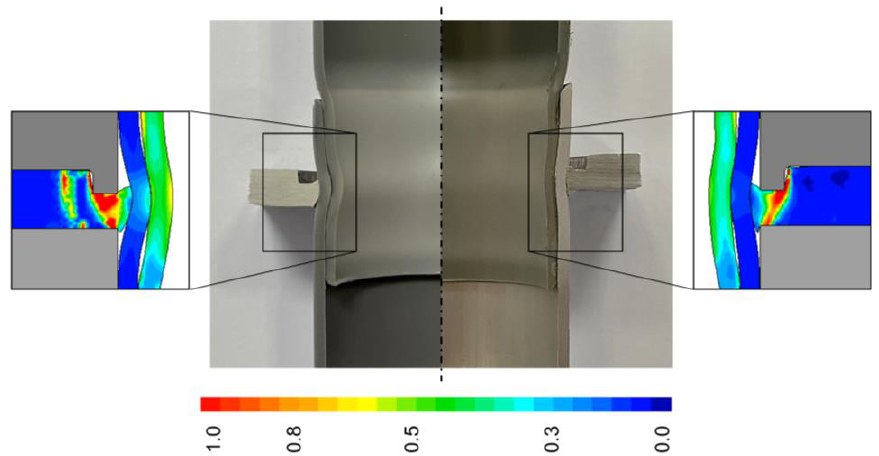
Figure 7. Distribution of effective strain for a connection between two PVC tubes ( left ) and an inner tube of PVC and an outer tube of aluminum ( right ). The respective photograph of each correspondent experimental specimen is also included.